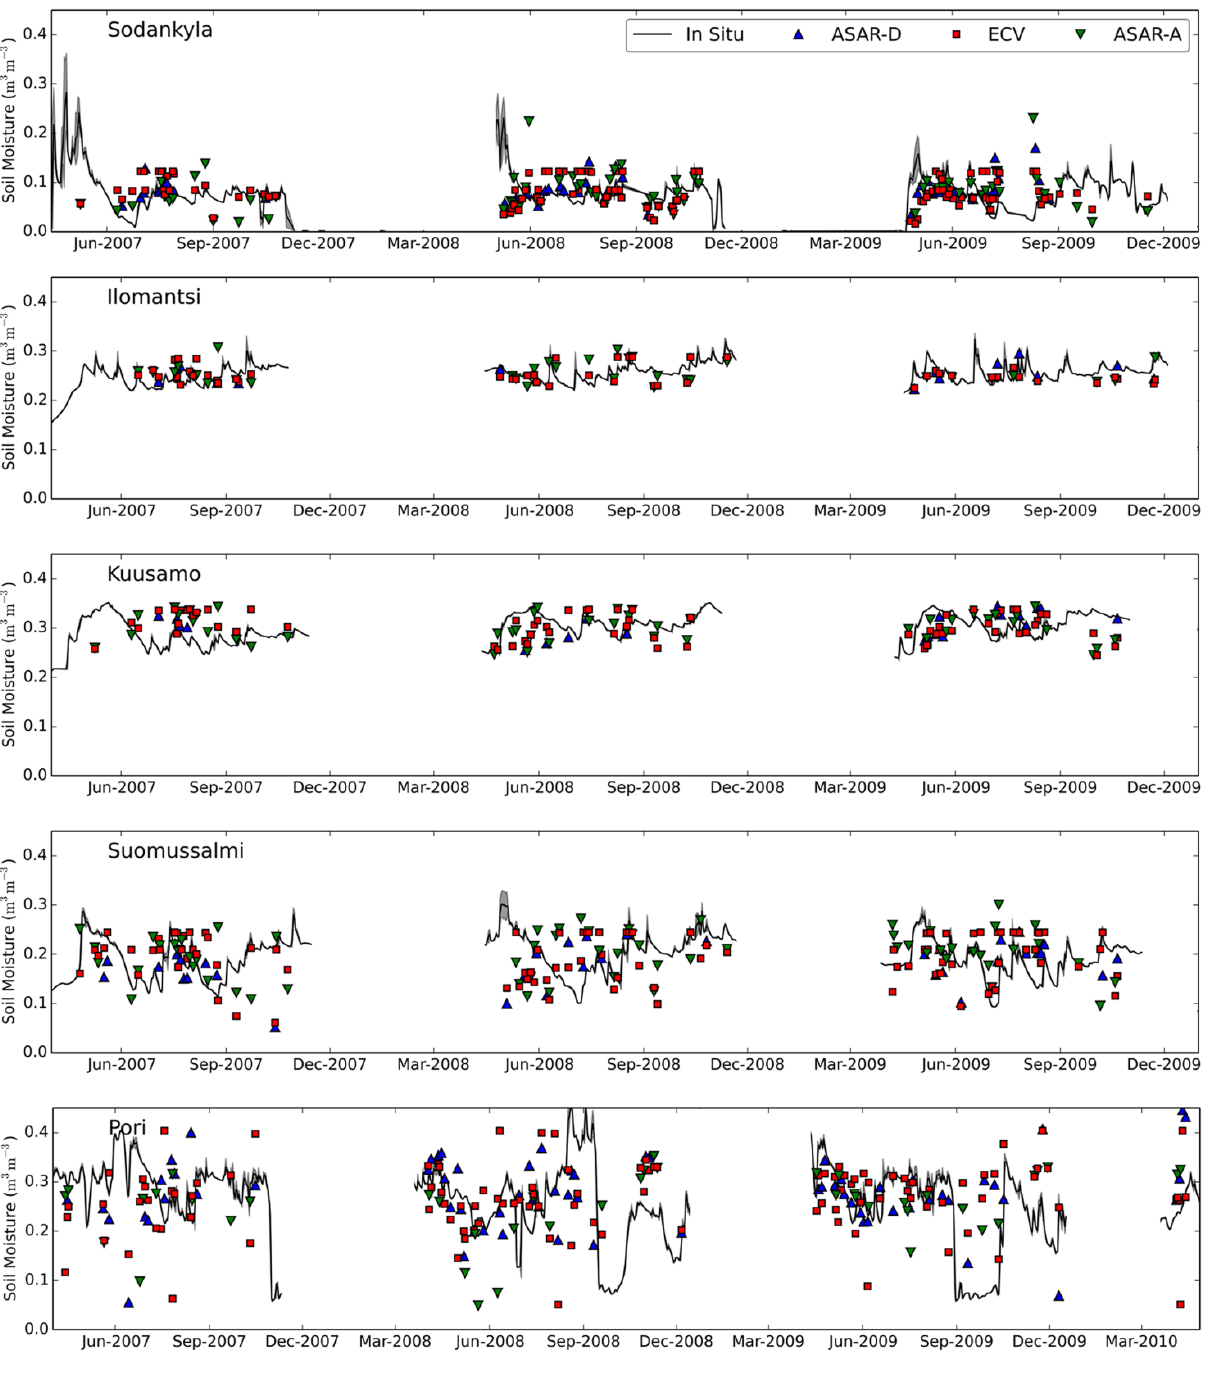
Figure 4. Time series of in situ (continuous black line), ASAR (descending (blue triangle) and ascending (green triangle) passes), and ECV (red square) soil moisture values for each Finnish ECV